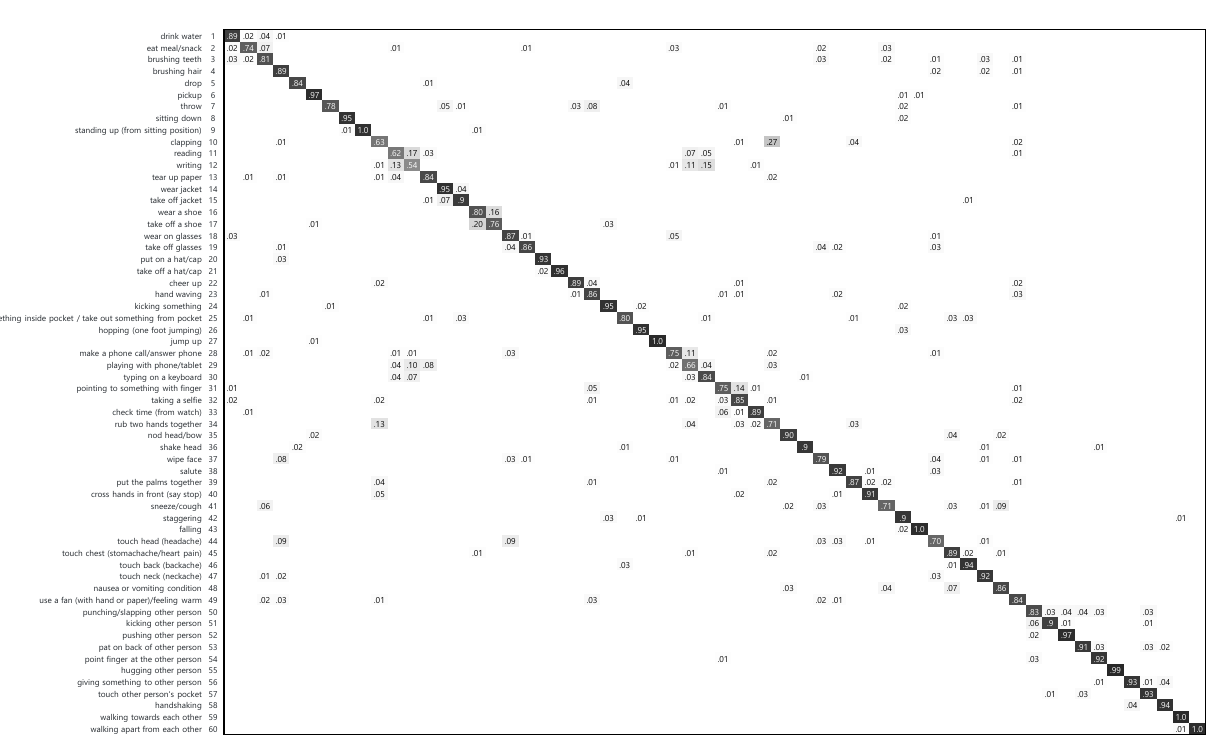
Figure 5. Confusion matrix of the proposed temporal action head network (TAHNet-v1) on the CS evaluation of the NTU RGB + D dataset. The overall accuracy is